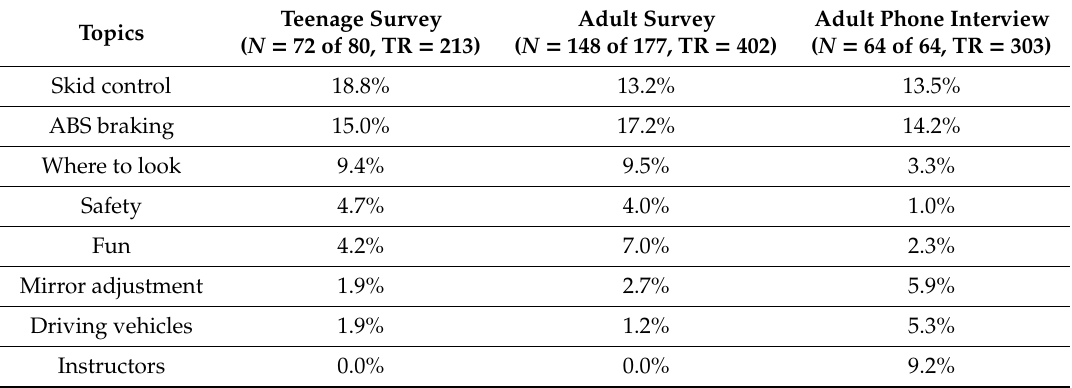
Table 3. Results for the top things from the CCC for the teenage survey, adult survey and adult phone interview. TR equals the total number of responses for a